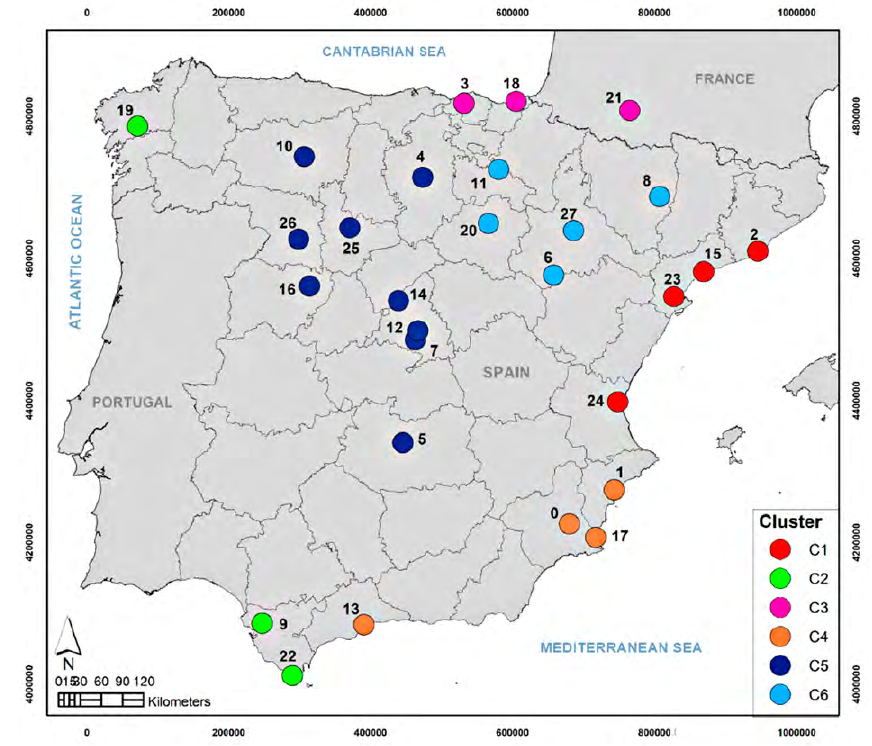
Figure 1. Spatial distribution of the meteorological observatories grouped by cluster, for the period 1950-2018. Table 1. Characteristics of the meteorological observatories in the study